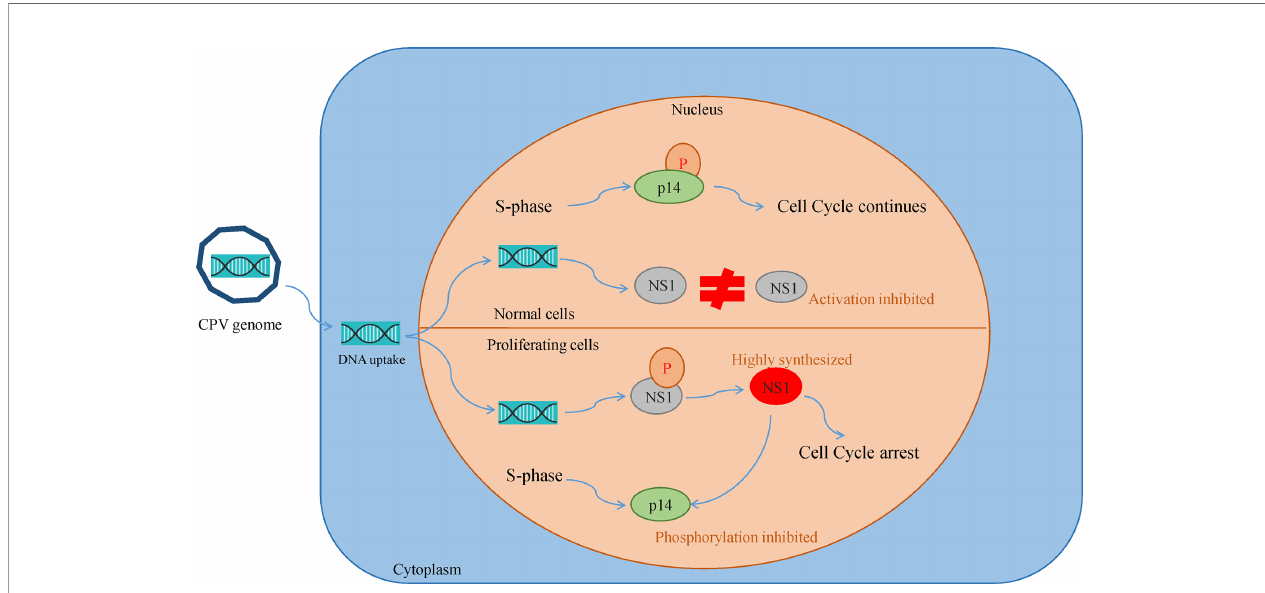
FIGURE 3 | Oncotropism of CPV.NS1 in proliferating/transformed cells: CPV2.NS1 needs to be phosphorylated for activation. NS1 competes with a 14 kda protein (p14) for phosphorylation as both are phosphorylated at serine residues by the same protein kinase C family members. In normal cells, p14 undergoes phosphorylation, despite NS1 synthesis thereby preventing cell cycle arrest whereas, in proliferating cancer cells, NS1 synthesis occurs in huge amounts which inhibits p14 phosphorylation leading to cell cycle arrest and